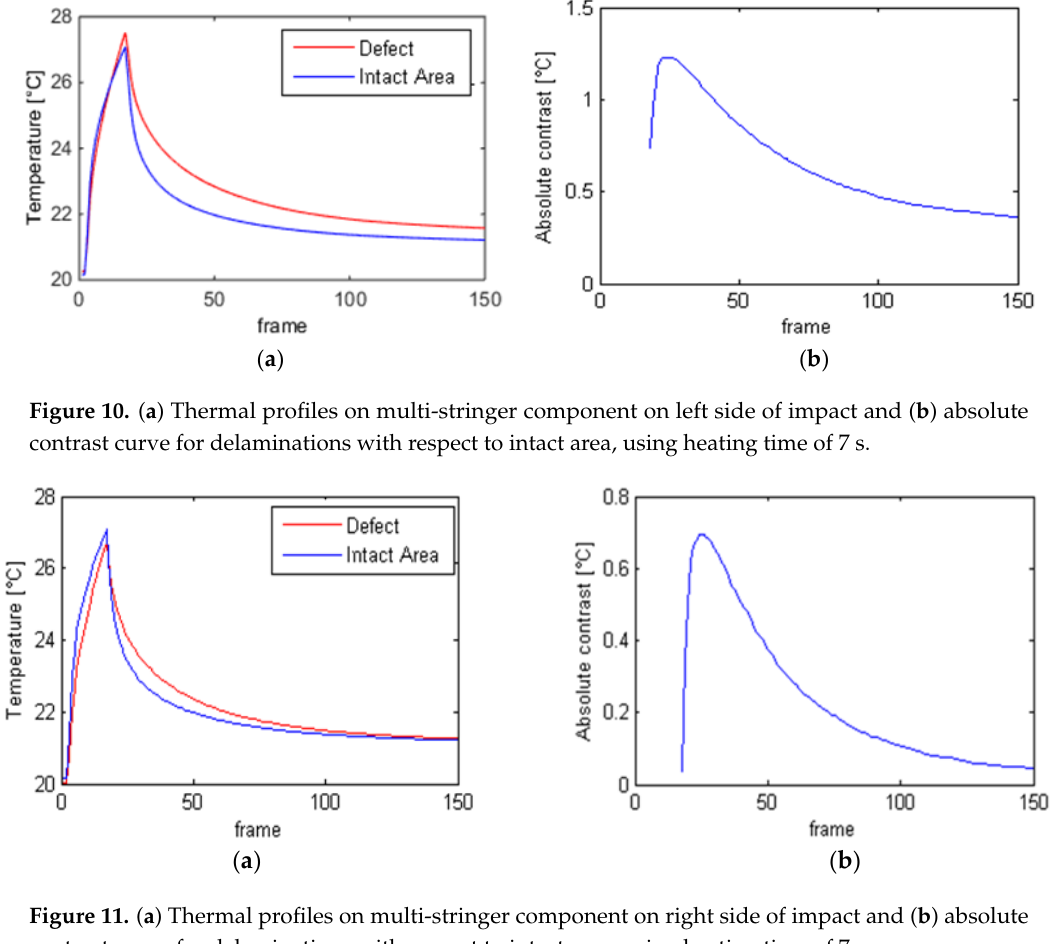
Figure 9. ( a ) Thermal profiles and ( b ) absolute contrast example for defect-2 (Ø 10 mm) and intact area in Plate I, using heating time of 20 s.